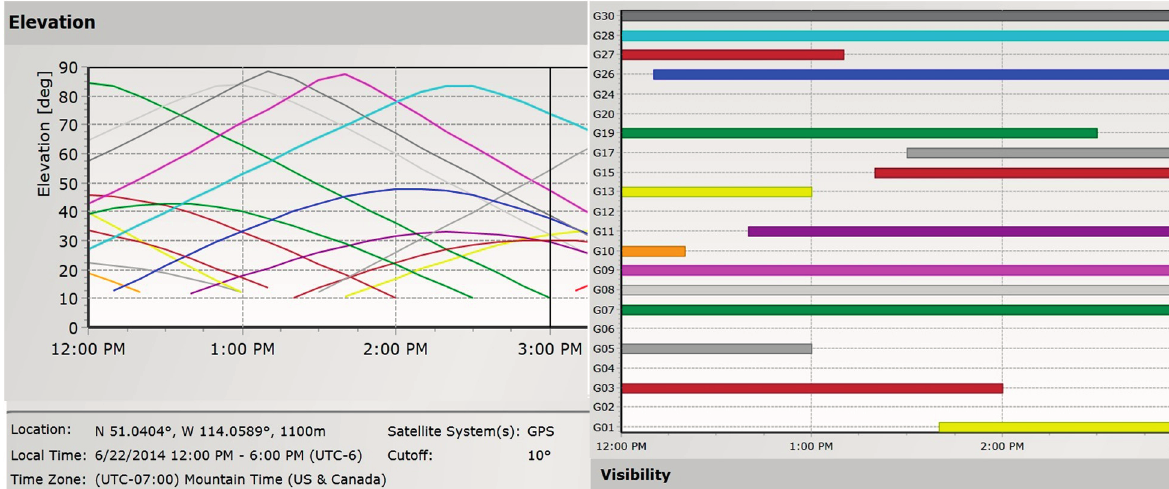
Figure 4. Availability and elevation angles of satellites during test